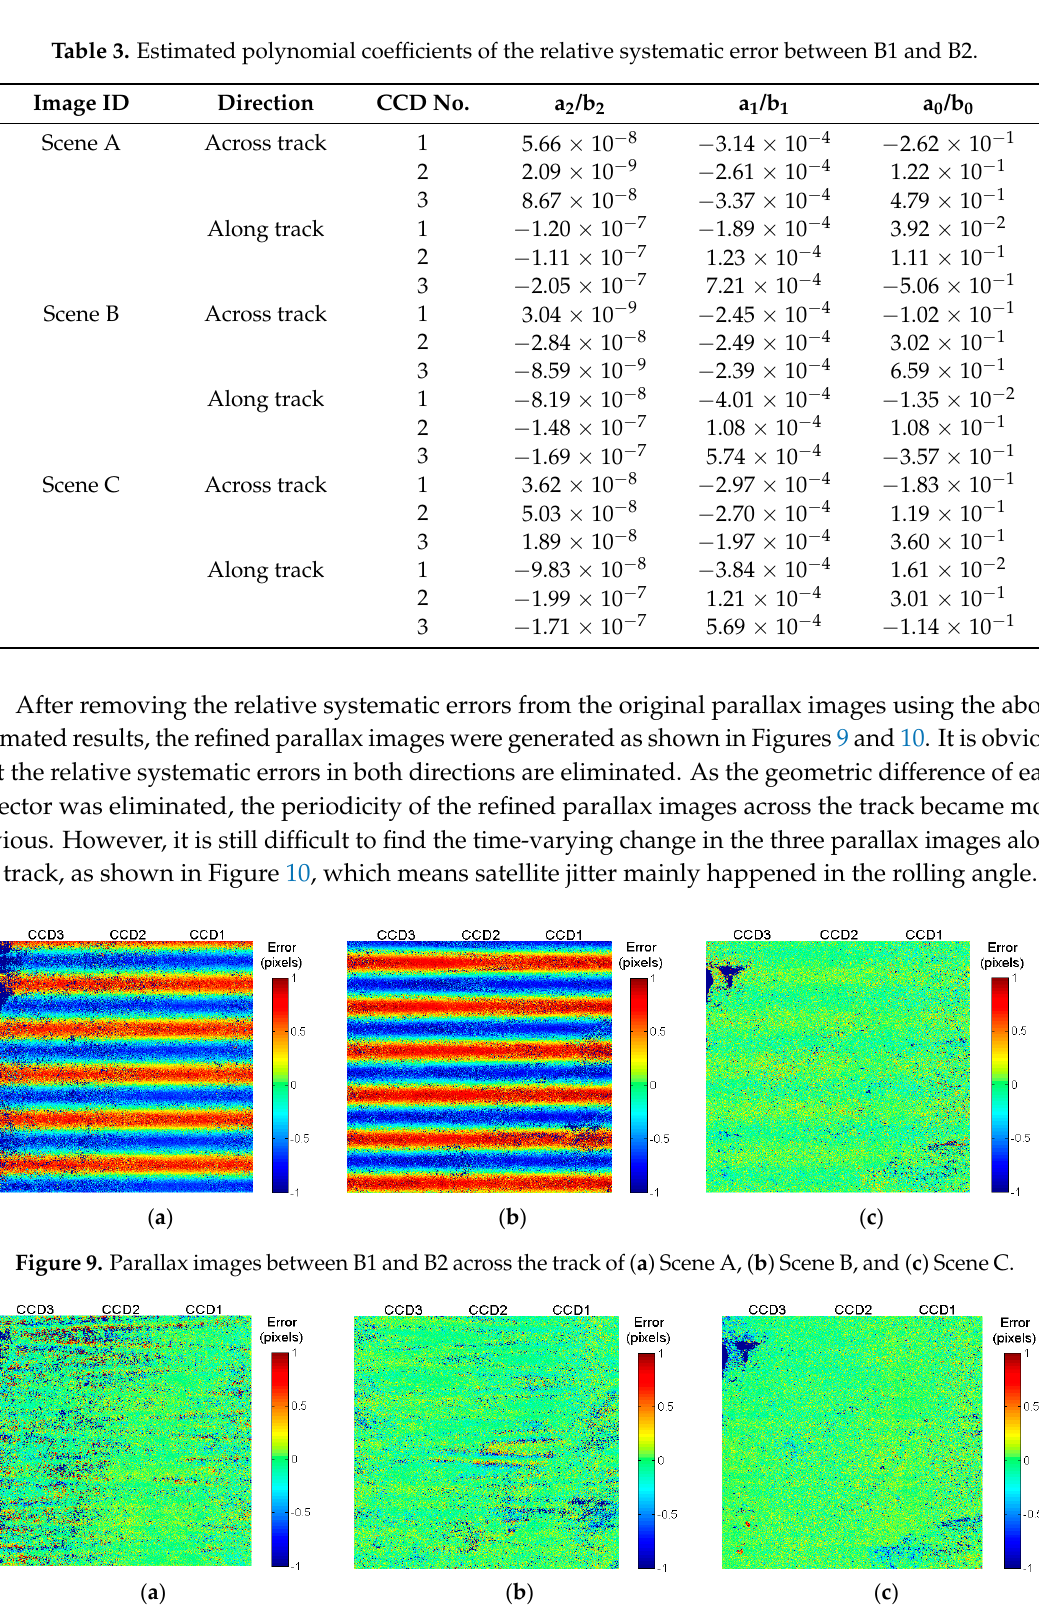
Figure 8. Relative systematic error between B1 and B2 in Scene C. ( a ) Across the track and ( b ) along the track. Table 3. Estimated polynomial coefficients of the relative systematic error between B1 and B2.